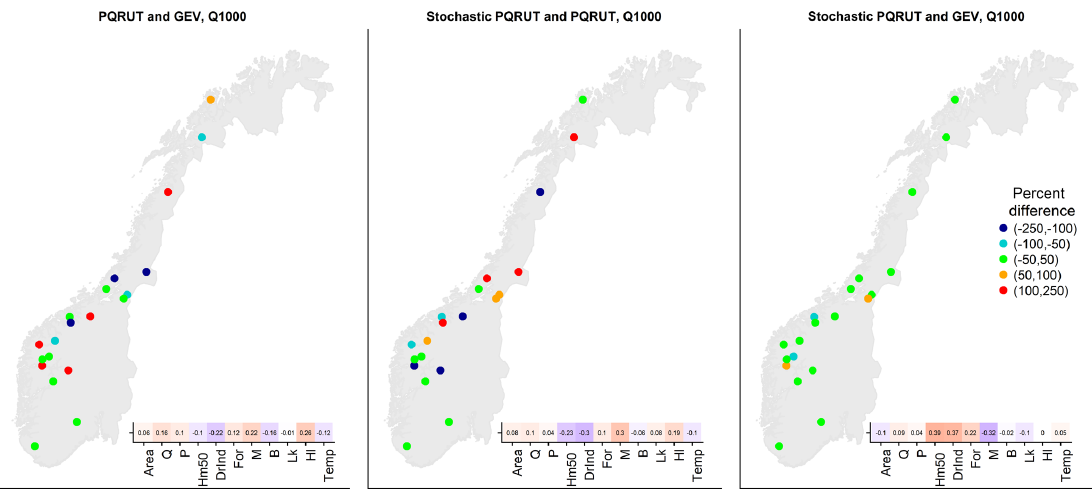
Figure 13. Results of the comparison between stochastic PQRUT, PQRUT and GEV for the values of the 1000-year return level. The absolute differences (calculated by dividing the estimate by the average of all models) are correlated with catchment properties. Positive correlations are given by red and negative correlations by